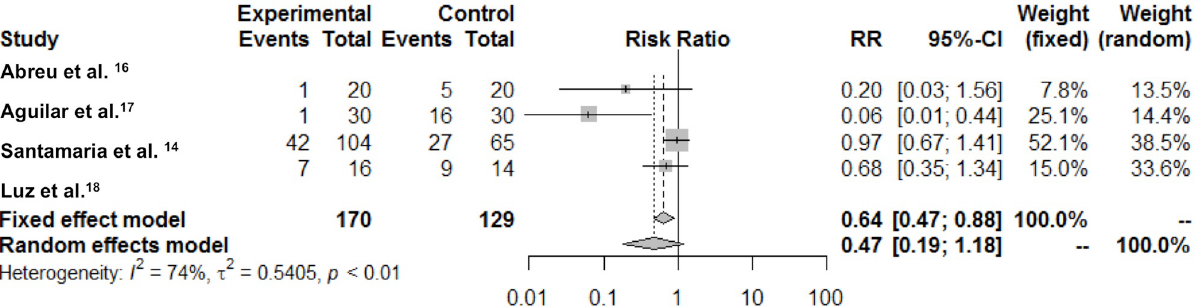
Fig 4. Forest plot comparing treatments with versus without rotary instruments and local anesthesia regarding self-reported pain.